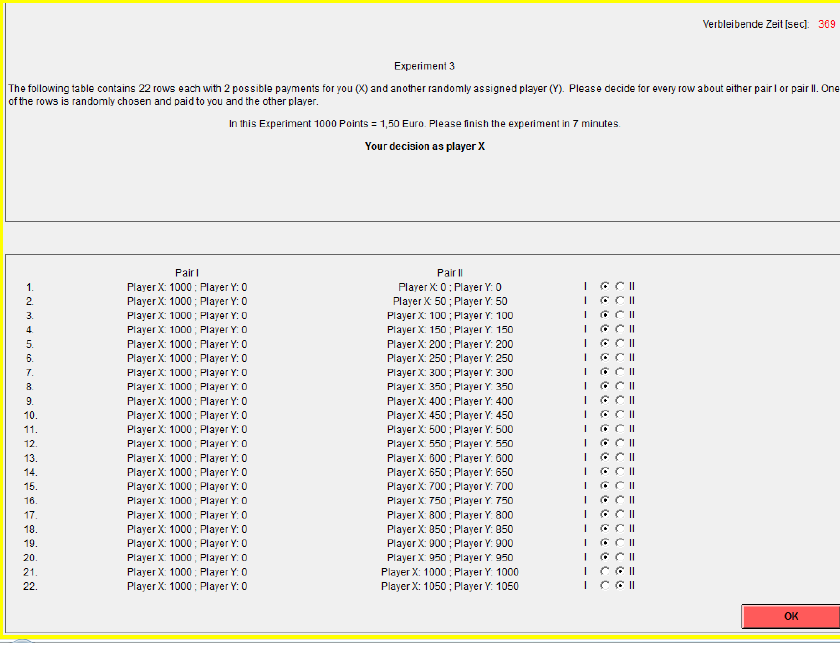
Figure A2. Z-Tree Screenshot of Elicitation of Favored Inequality Aversion. Notes: Players have to decide upon one of each column in every row. The procedure is as proposed by Danneberg et al. 2007.